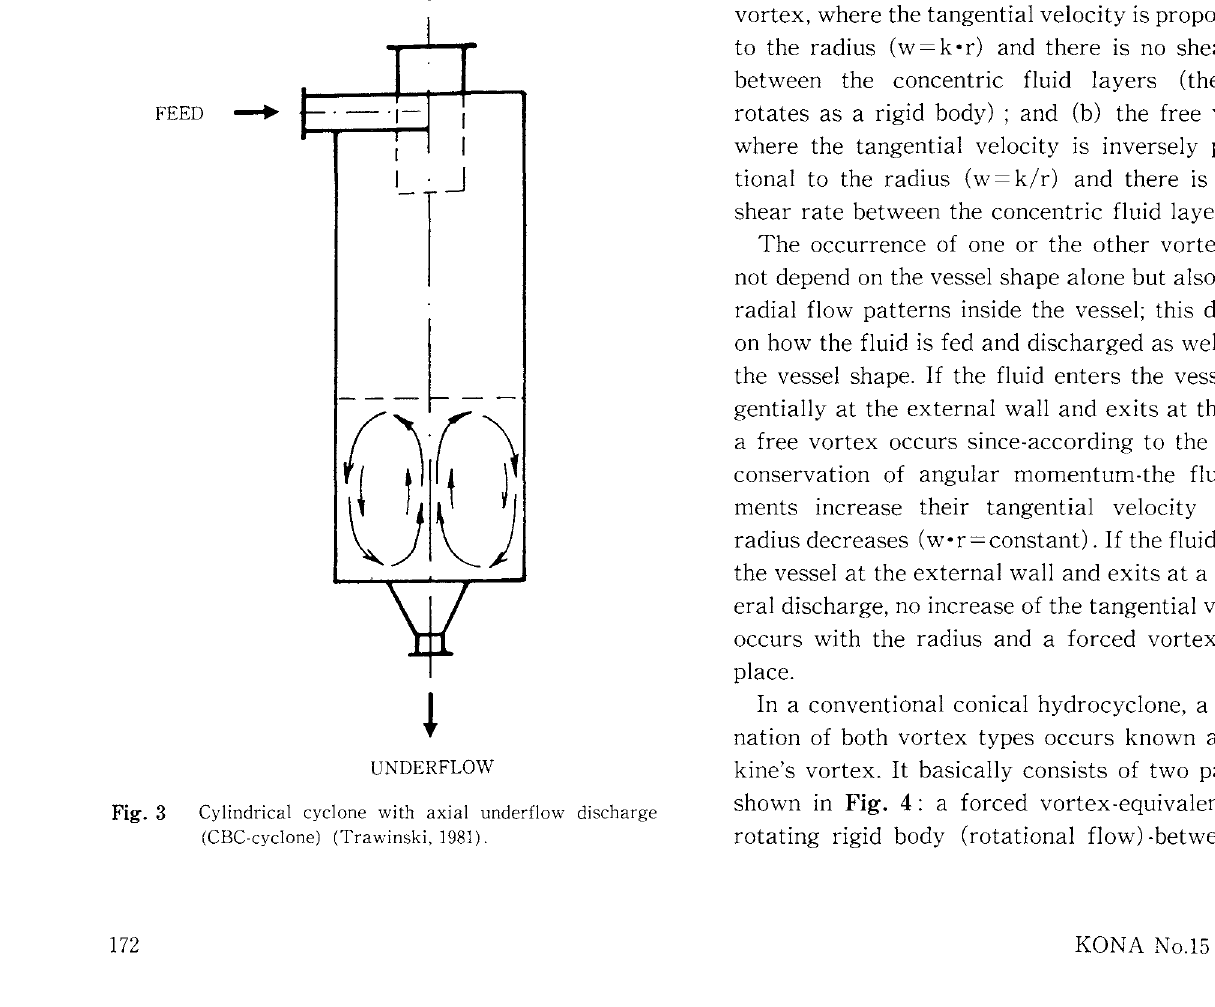
Fig. 3 Cylindrical cyclone with axial underflow discharge (CBC-cyclone) (Trawinski,